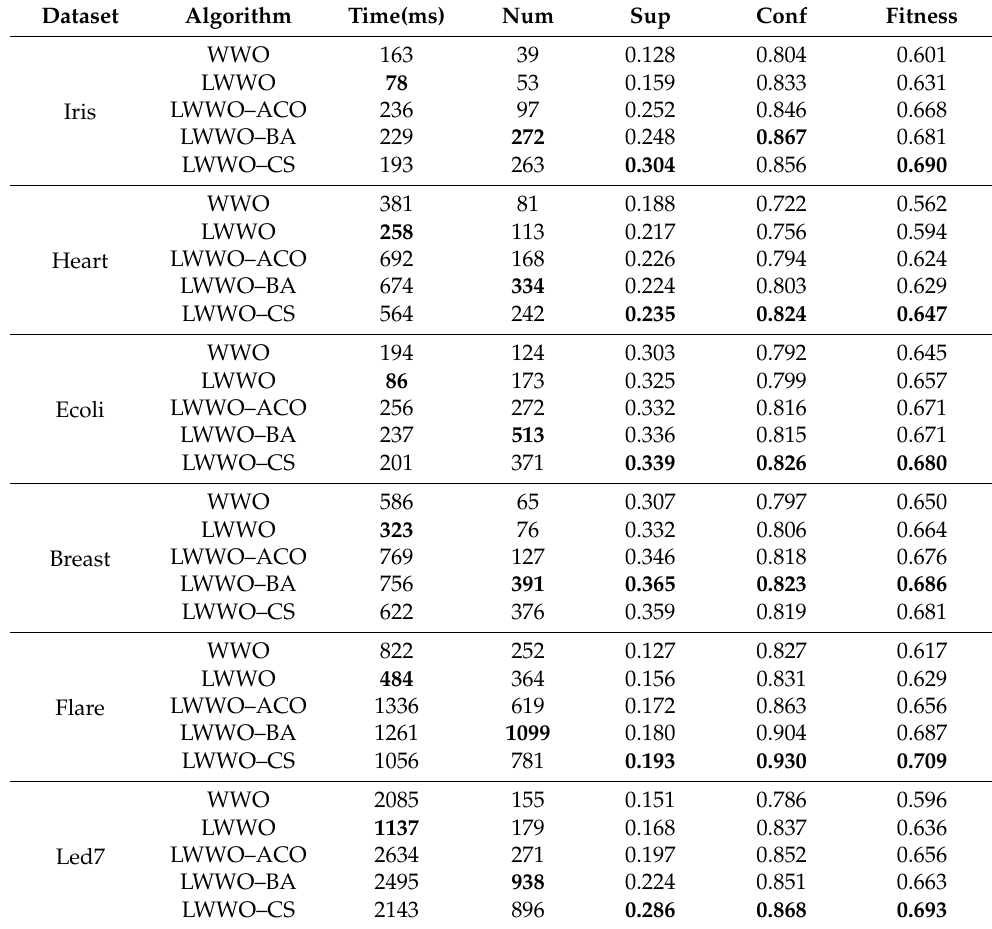
Table 5. Detailed data of each algorithm on different datasets.